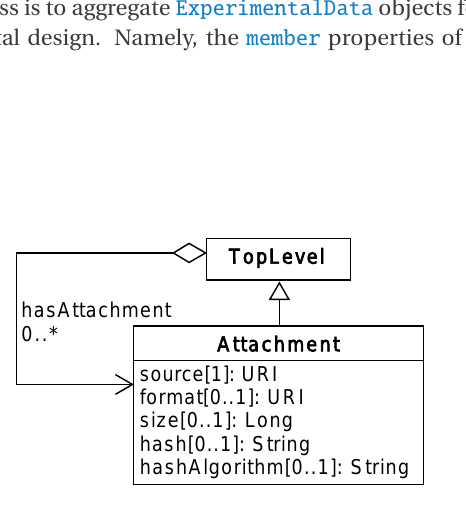
Figure 21: Diagram of the Attachment class and its associated